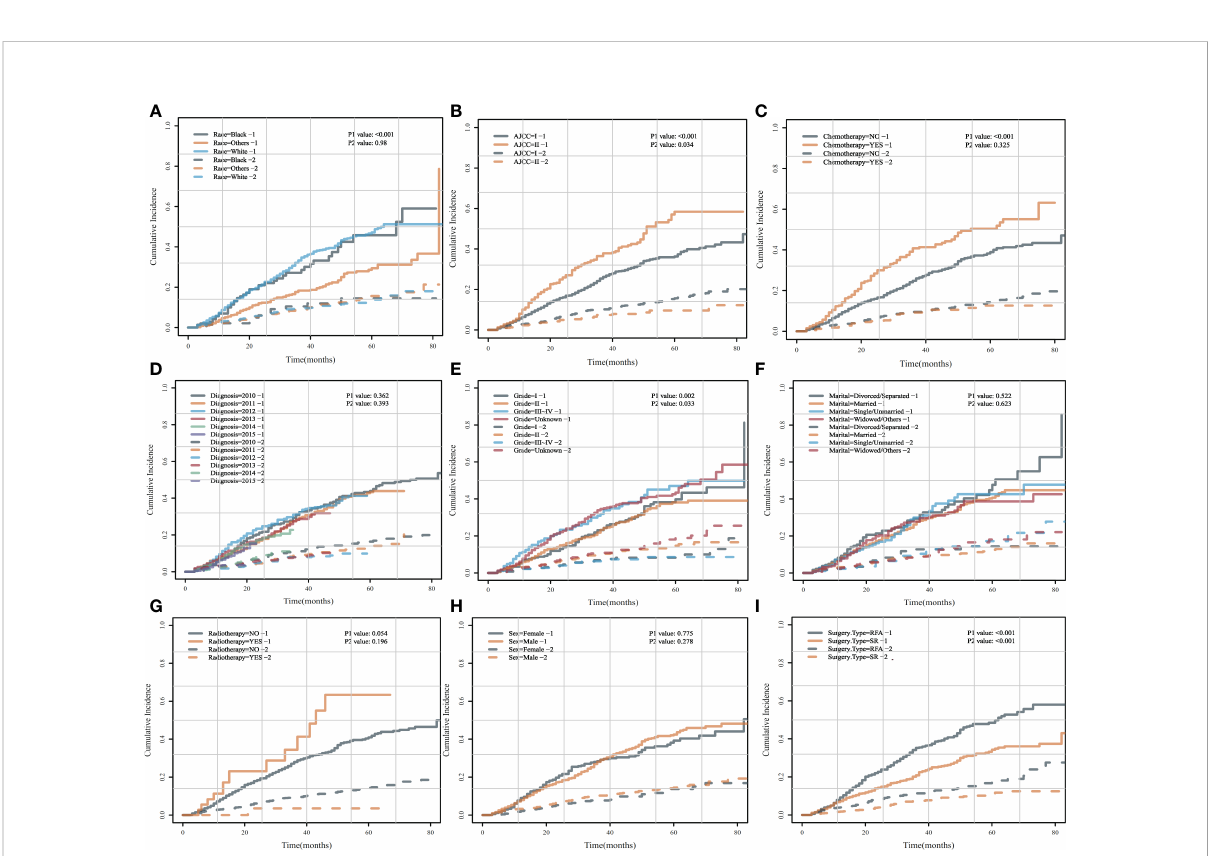
FIGURE 4 Cumulative incidence curves for each characteristic before PSM. (A) HCSD/OCSD cumulative incidence curves in HCC patients of different races (A) , AJCC (B) , chemotherapy (C) , diagnosis (D) , grade (E) , marital (F) , radiotherapy (G) , gender (H) , surgery type (I) group with SR or SFA before PSM.